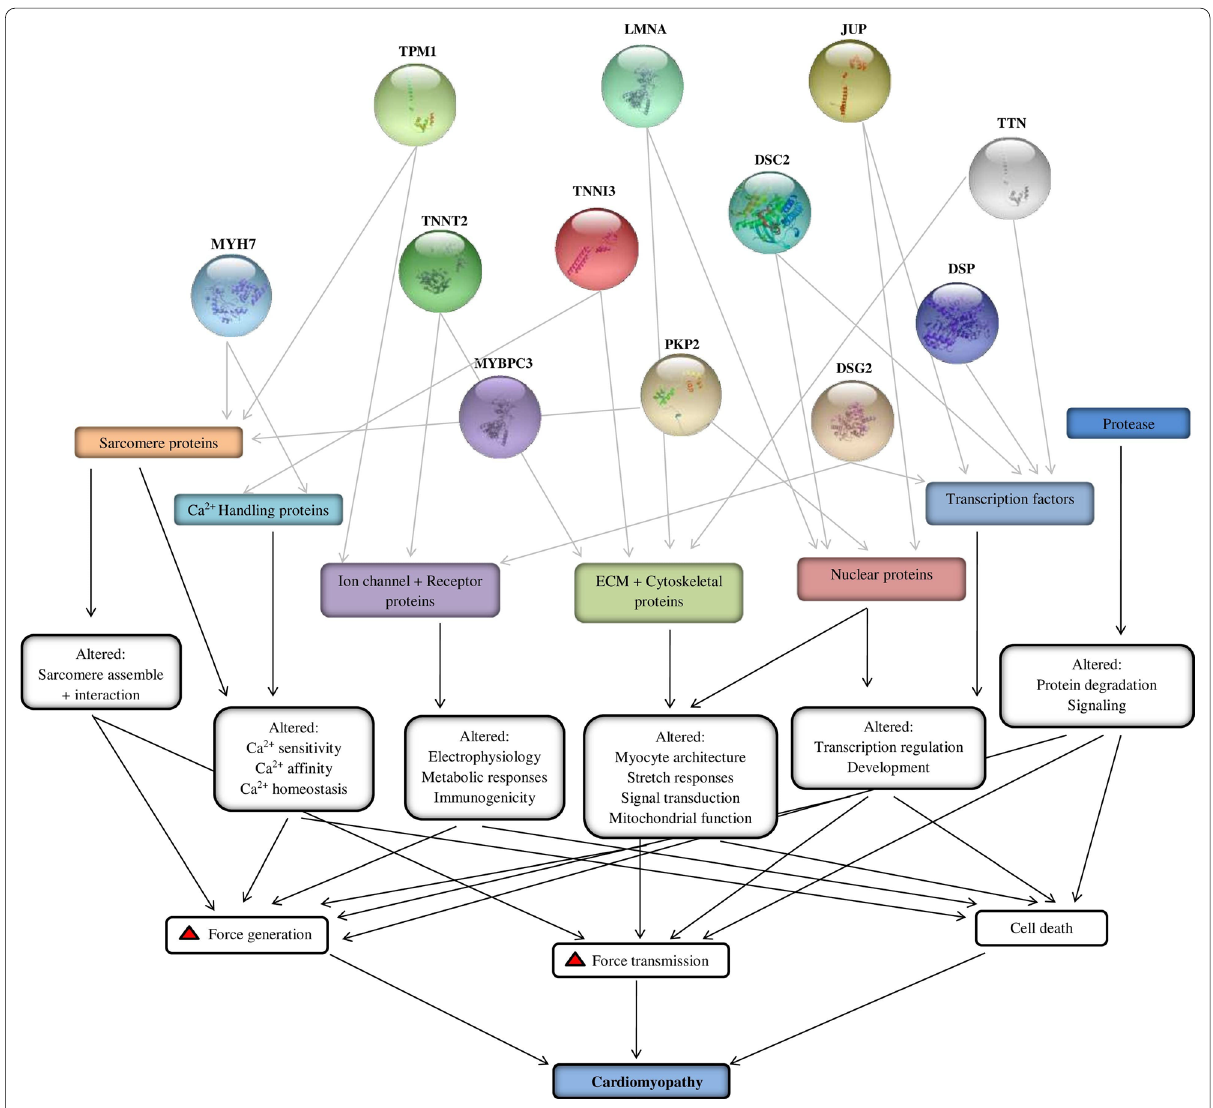
Fig. 4 Role of selected genes in